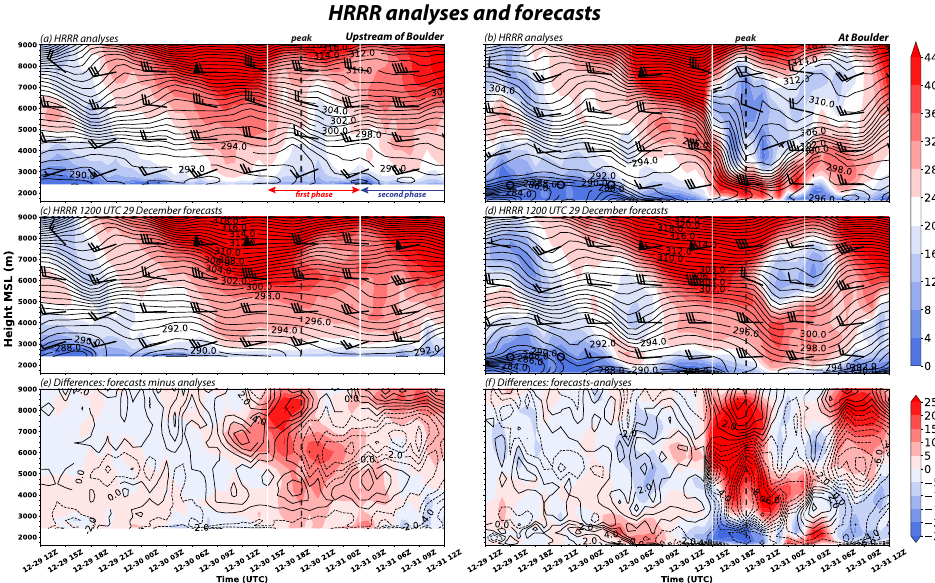
Figure 4. Hovmöller diagrams of time (UTC) vs. height (MSL) presenting wind speed (shaded, m/s), selected wind barbs (m/s), and potential temperature (1 K contours) for the inflow environment (left column) and Boulder (right column), representing ( a , b ) HRRR analyses or ( c , d ) HRRR forecasts from the 1200 UTC 20 December model run. Panels ( e , f ) represent wind speed (shaded, m/s) and potential temperature (1 K contours) difference fields, made by subtracting the analyses from the forecasts. Upstream location (elevation ≈ 2500 m MSL) shown on Figure 3 insets and other